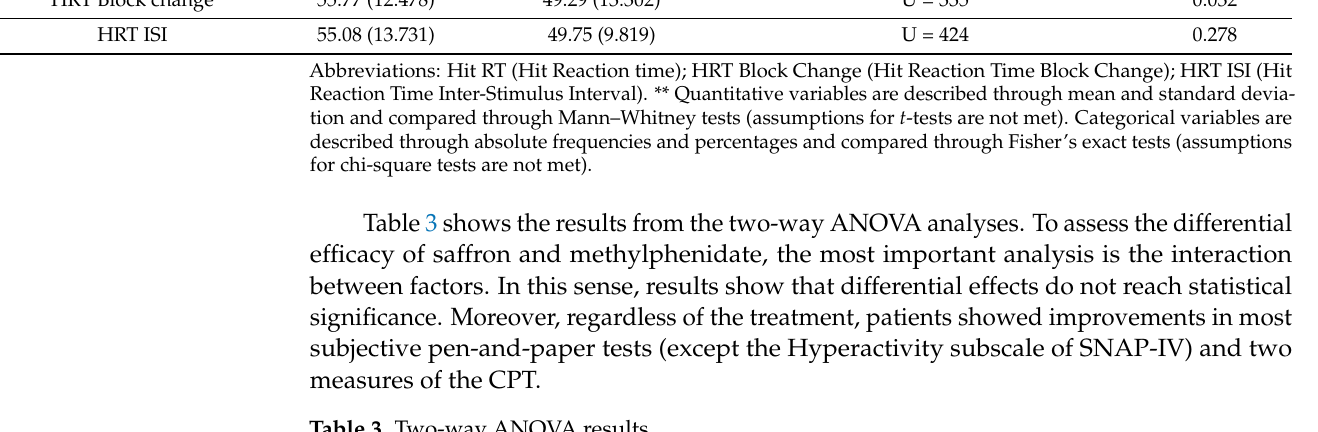
Table 3. Two-way ANOVA